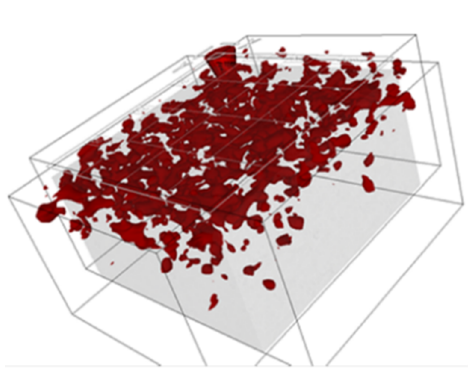
Figure 6. Two-dimensional visualisation of data obtained by the radar-based technique.